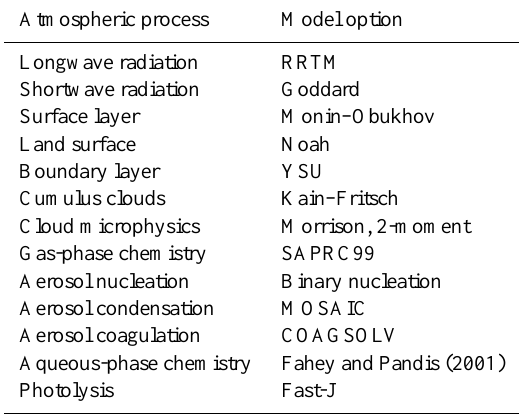
Table 2. Meteorological and chemical process options used in this